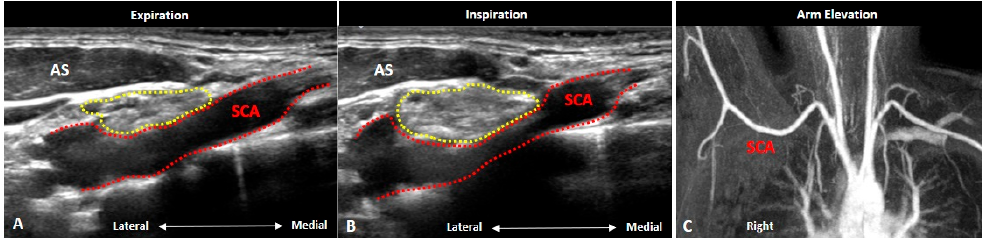
Figure 15. Ultrasound imaging of thoracic outlet syndrome caused by subclavian artery compression in a young woman suffering right arm pain during inspiration. Ultrasound images during expiration ( A ) and inspiration ( B ) showed sudden narrowing of the subclavian artery during inspiration (red dashed area). Focal stenosis of the subclavian artery was not obvious in the magnetic resonance angiography during right arm elevation ( C ). Inferior trunk: yellow dashed area. AS: anterior scalene muscle; SCA: subclavian